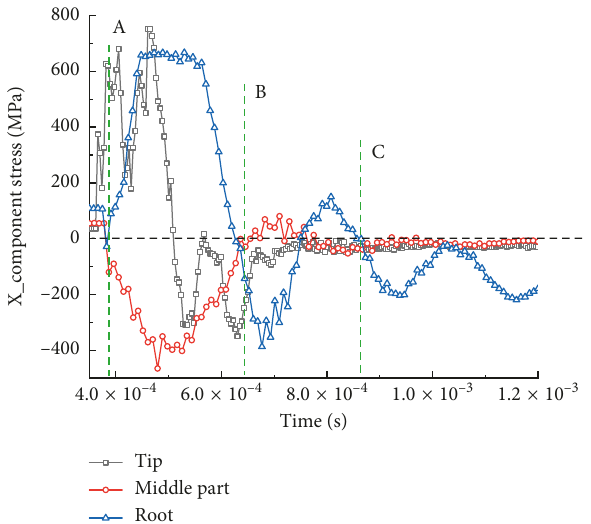
Figure 17: Time history of the radial stress on rubbing blade.